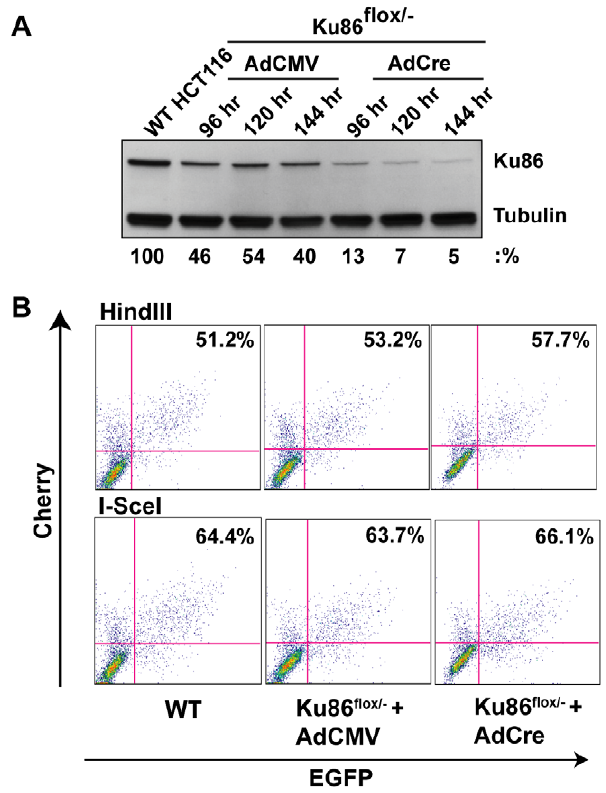
Figure 4. Ku86-null cells show wild-type levels of end joining activity. (A) Western blot analysis shows that the expression of Cre (AdCre) in Ku86 flox/ 2 cells results in the reduction of Ku86 expression. AdCMV is a negative control adenoviral vector. (B) the indicated cell lines were transfected with either HindIII- (Top panels) or I-SceI- (bottom panels) linearized pEGFP-Pem1-Ad2 plasmid. All symbols are as in Figure 3.